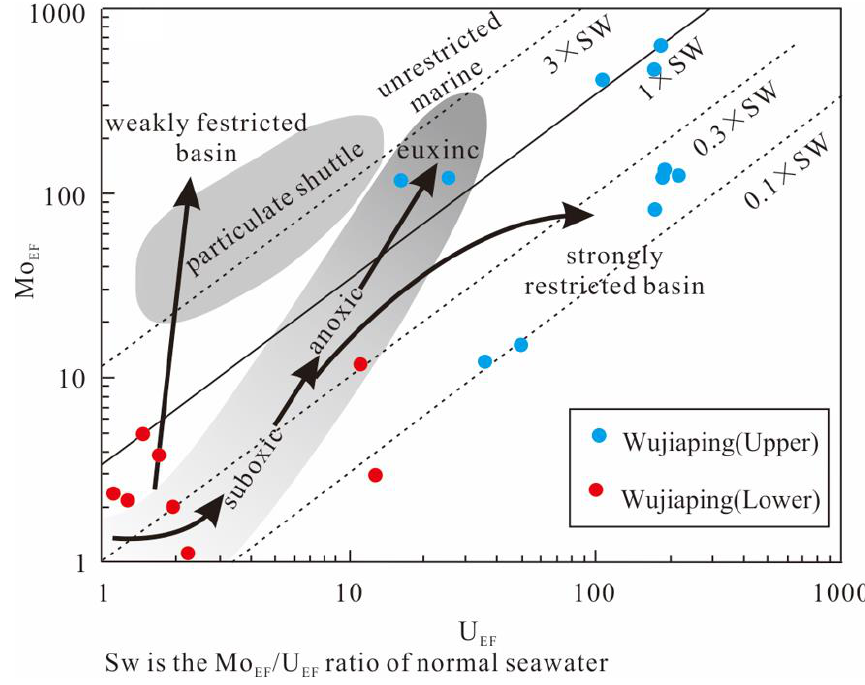
Figure 5. Mo EF -U EF covariant mode for the Wujiaping Formation shale’s samples.